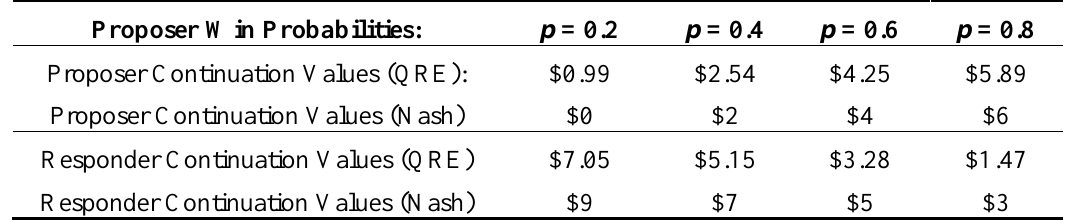
Table 5. Continuation Values Inferred From Quantal Response (QRE) and Nash